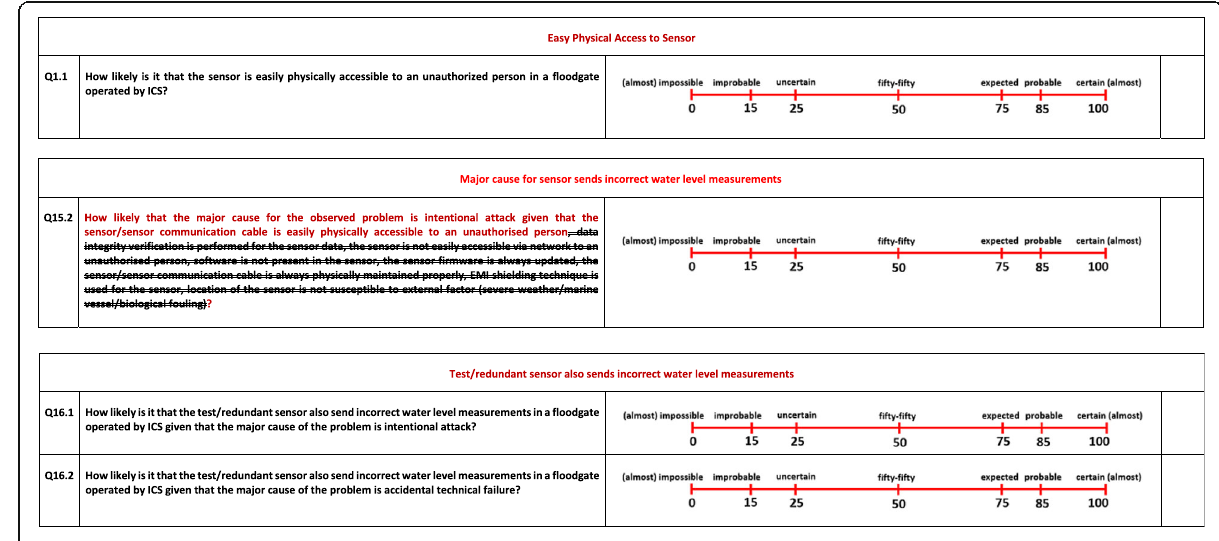
Fig. 5 Focus Group Workshop – Example